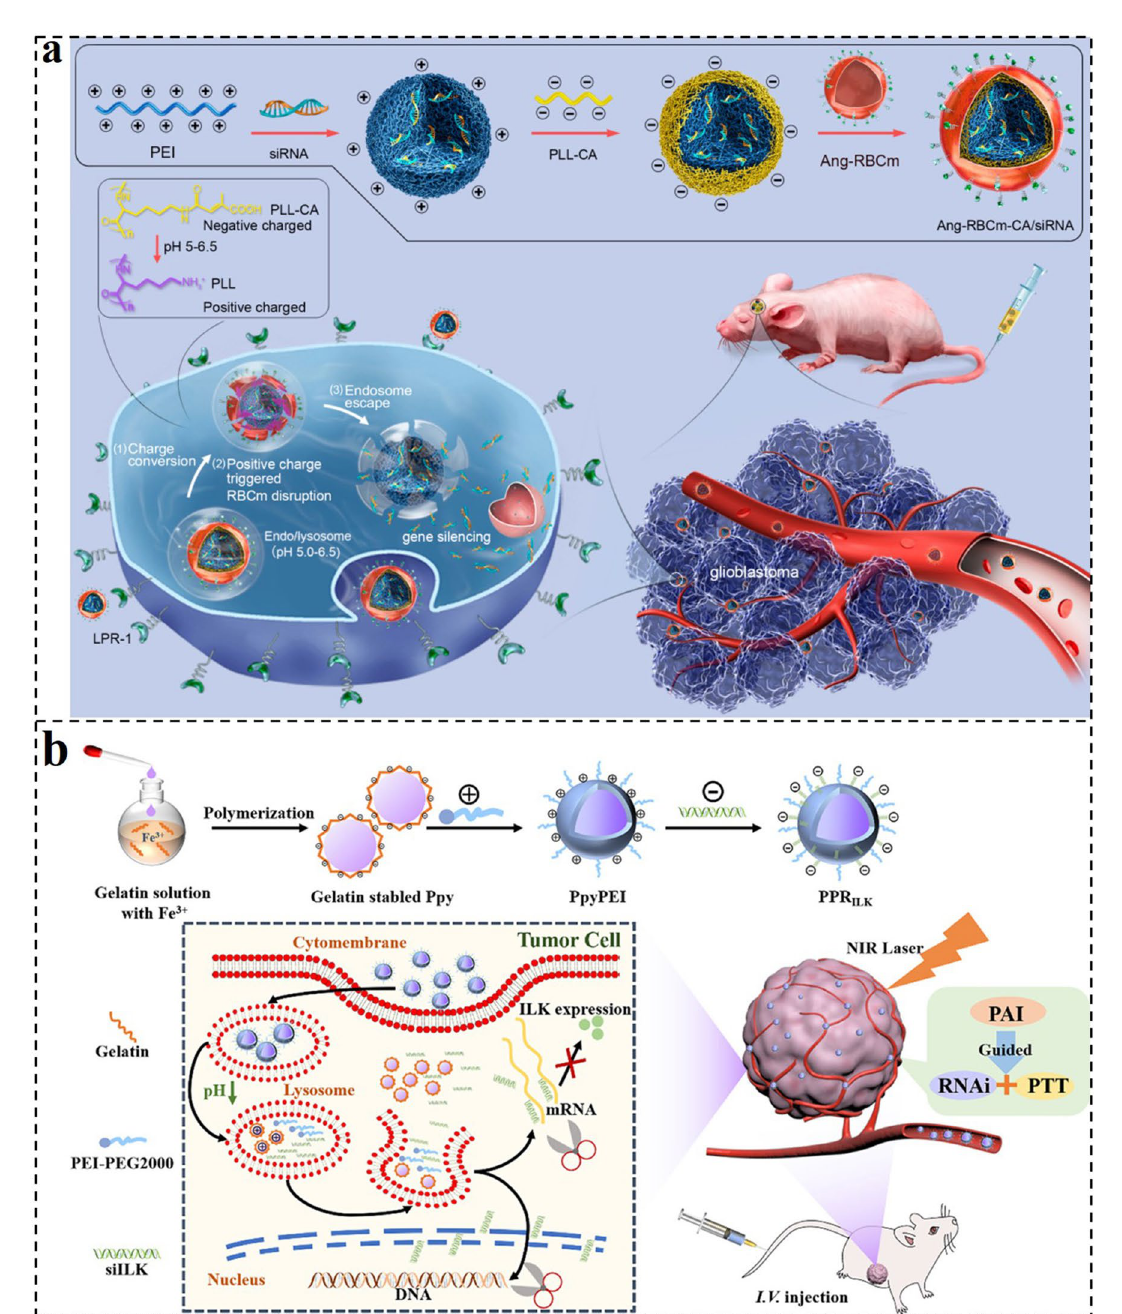
Fig. 2 a Preparation and therapeutic processes of Ang-RBCm-CA/siRNA. Ang-RBCm-CA/siRNA boasts a long circulation time, enhanced BBB penetration, efficient cell uptake via LPR overexpressing U87MG glioblastoma cancer cells, charge conversion, and membrane disruption triggered by endosomal low pH and siRNA release, culminating in the effective treatment of orthotopic U87MG human glioblastoma in tumor- bearing nude mice [151]. Copyright 2020, American Chemical Society. b Illustration of the fabrication and structure of the PPR ILK nanocomplex and its functions for combined photothermal and gene therapy in PTC [152]. Copyright 2022, American Chemical